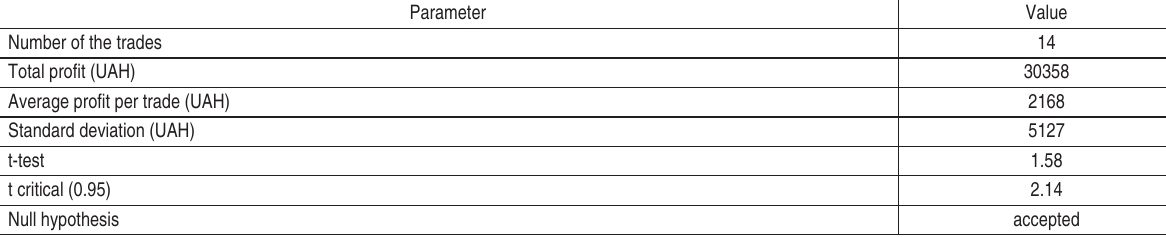
Table 10. T-test for the trading simulation results for the Halloween effect (PFTS